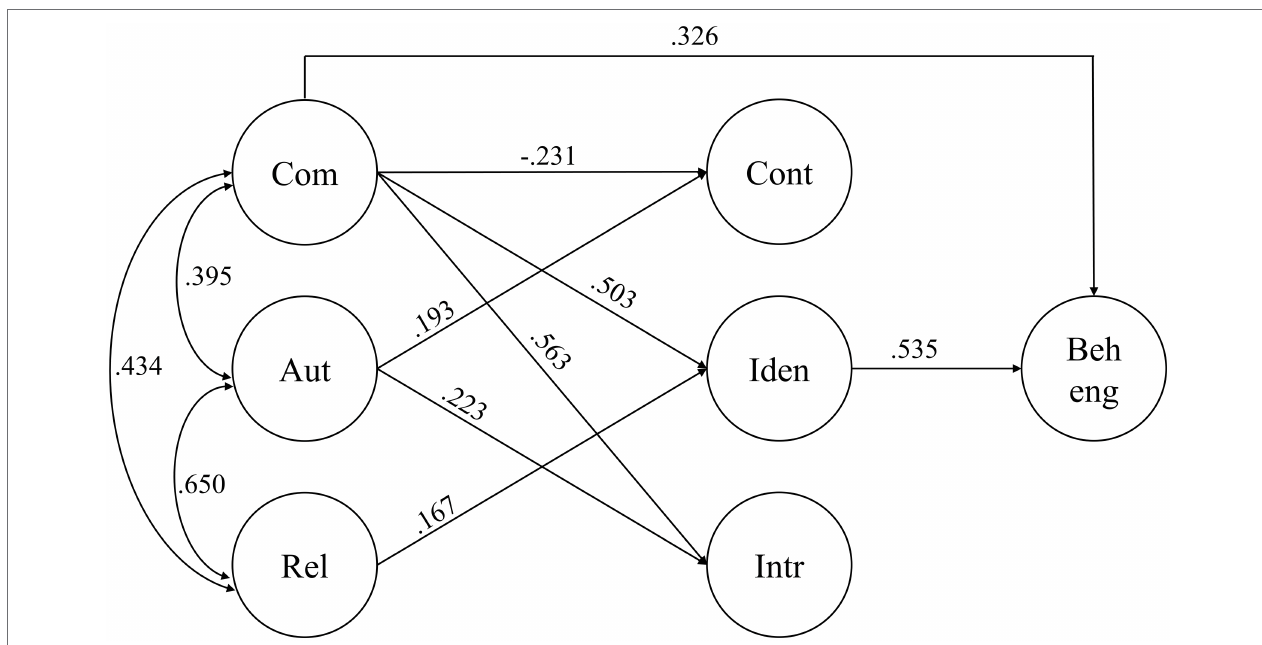
FIGURE 2 | Path diagram describing the structural relations between the latent variables of the alternative model. All observed variables are excluded in this diagram, and only significant paths are shown ( p < 0.05). All coefficients are standardized. Com, perceived competence; Aut, perceived autonomy; Rel, perceived relatedness; Cont, controlled motivation; Iden, identified regulation; Intr, intrinsic regulation; and Beh eng, behavioral